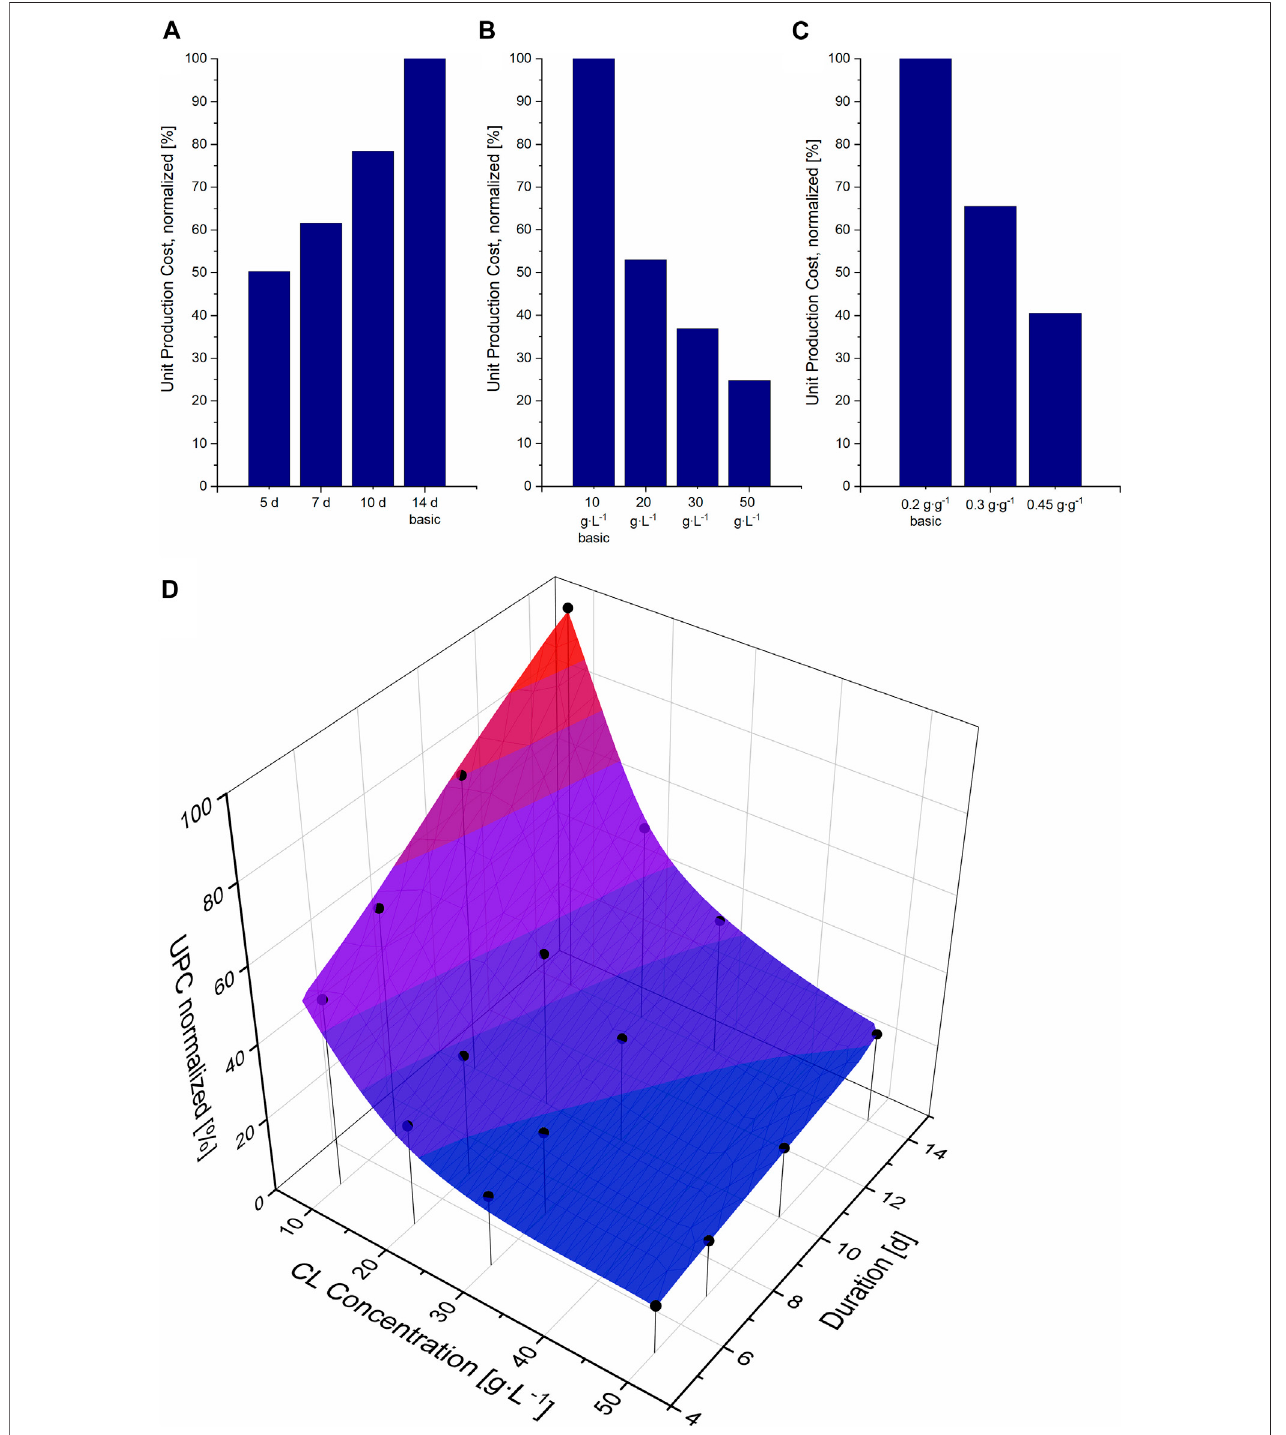
FIGURE 2 | Unit production cost (UPC) per kg CL, normalized to the UPC for the basic scenario (14 days fermentation, 10 g L − 1 CL at a yield of 0.2 g g − 1 ), compared to different fermentation durations (A) , different CL concentrations (B) and yields (C) . (D) Surface cubic spline interpolation and simulated data points for the UPC at different fermentation durations and CL concentrations. The simulated data points are illustrated as black circles.